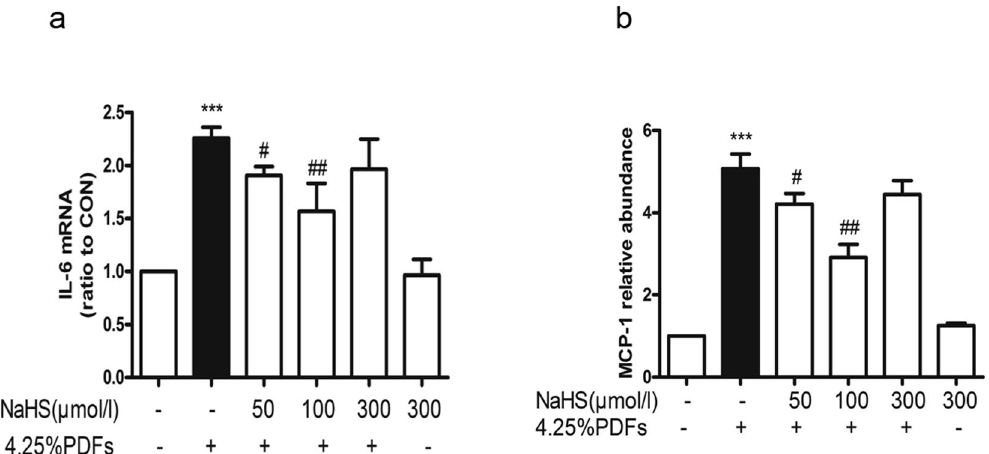
Figure 5. Effect of H 2 S on inflammatory factors induced by 4.25% glucose PDFs in RPMCs. RPMCs were pretreated with or without NaHS(50, 100, 300 μ mol/L) for 30 min and then exposed to the mixture of 4.25% glucose PDFs and culture medium by 1:1 for 6 h. ( a , b ) IL-6 and MCP-1 relative abundance of mRNA were normalized by β -actin RNA expression. Data represent mean ± SD of three independent experiments. *** P < 0.001 versus control group; ## P < 0.01, # P < 0.05 versus 4.25% glucose PDFs